Question: Write a single sentence explaining what this figure depicts.
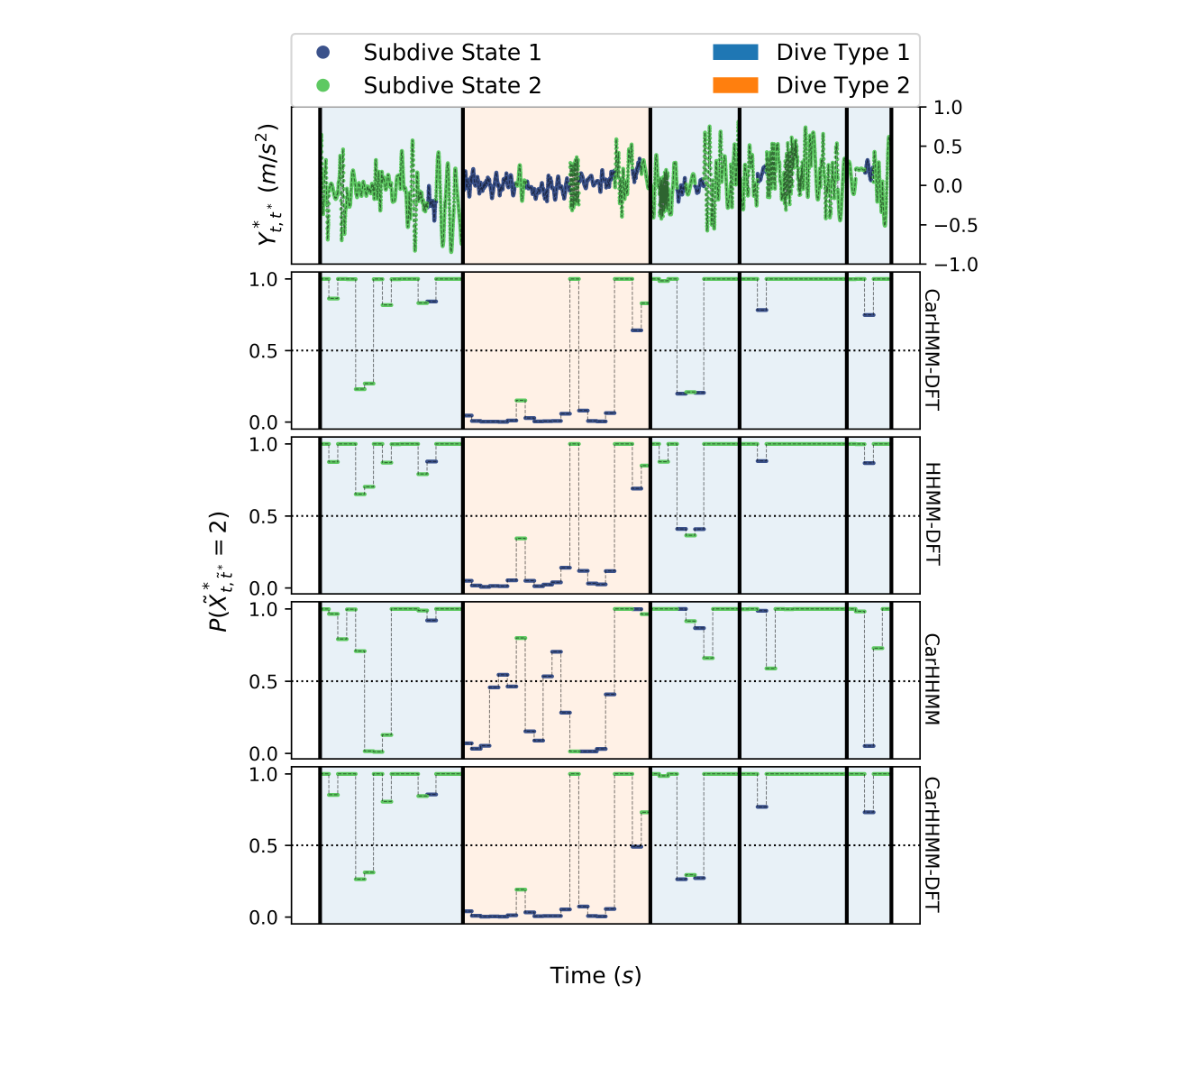
Answer: Estimated probabilities that each window corresponds to subdive state 2 for ﬁve selected dives of a simulated data set of killer whale dive behaviour. Each panel is partitioned into dives by vertical black lines. The colour of the curve corresponds to the true subdive state while the colour of the background corresponds to the true dive type.